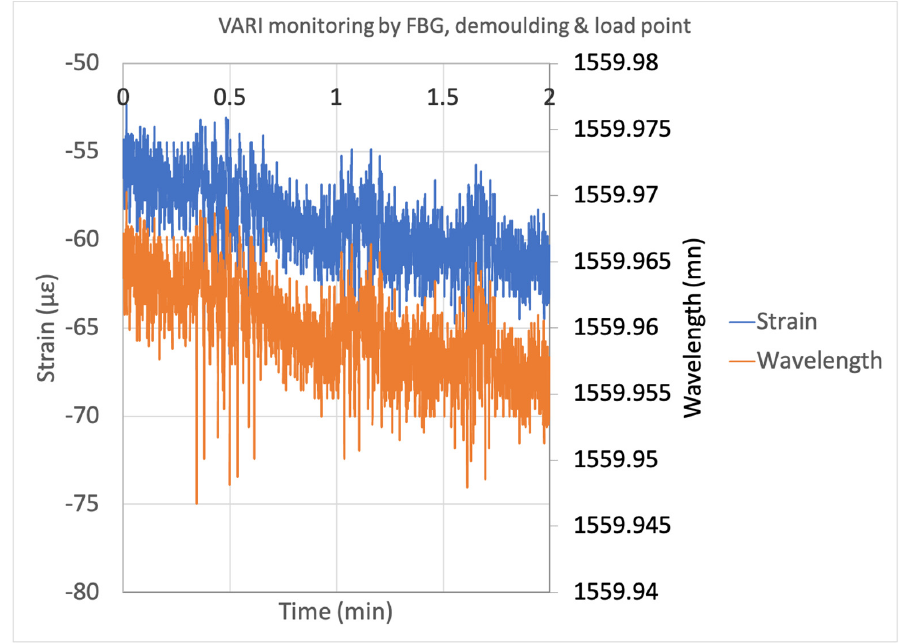
Figure 12. VARI monitoring by FBG, composite at room temperature with pressure loads.